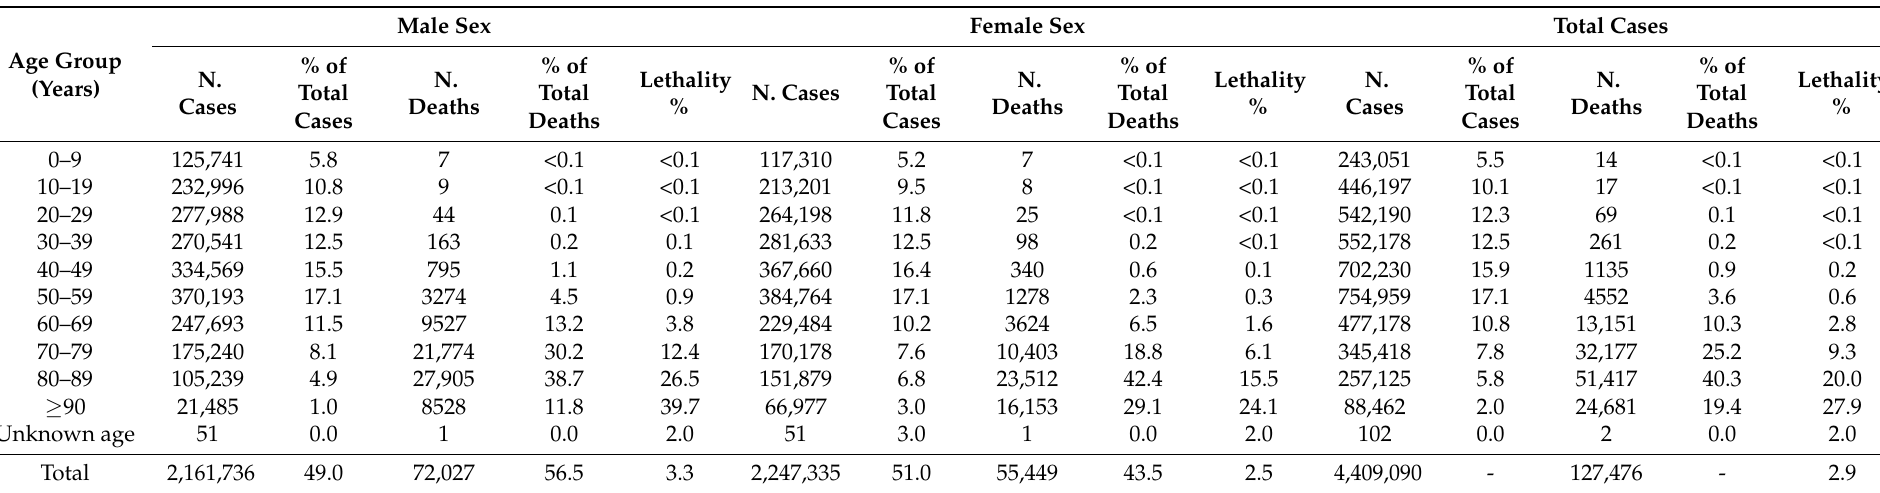
Table 1. Distribution of cases ( N = 4,409,090) and COVID-19 related deaths in Italy ( N = 127,476) stratified by age group and sex (produced by the Istituto Superiore di Sanit à (ISS), Rome. Data updated to 11 August 2021).